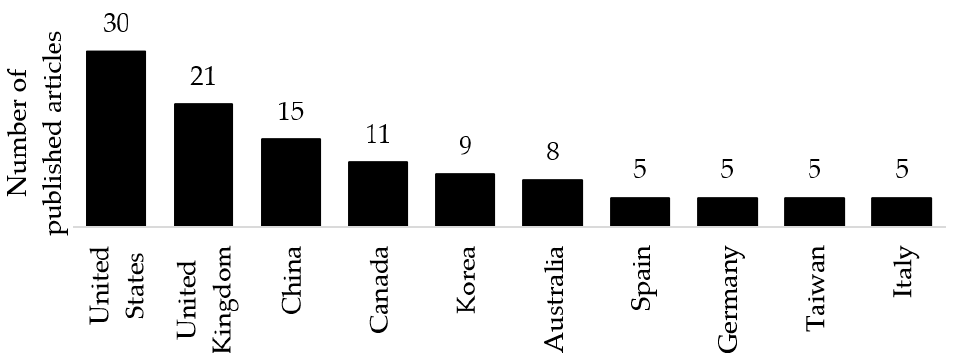
Figure 3. AI applied to FM papers published over the last decade and countries or territories (2012– 2021).